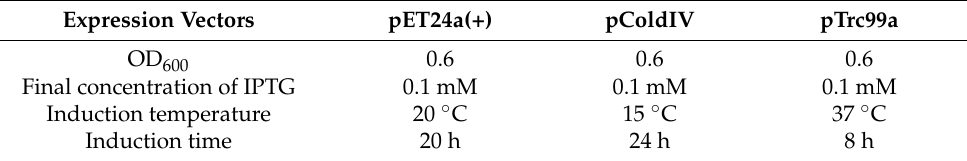
Table 2. Induction conditions for the pET-24a(+), pColdIV, and pTrc99a